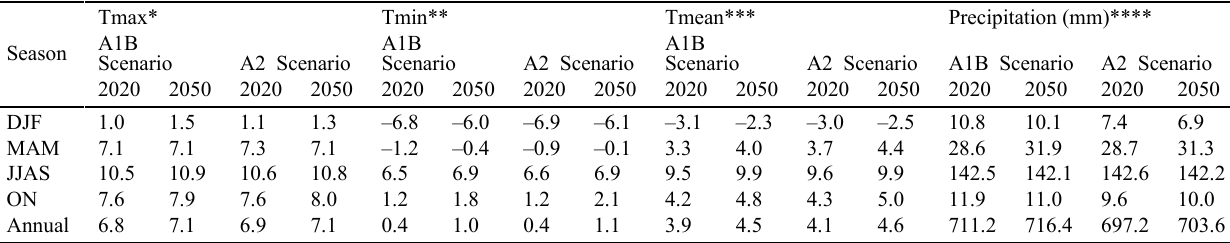
Table 3 Temperature and Precipitation both A1B and A2 Scenario.